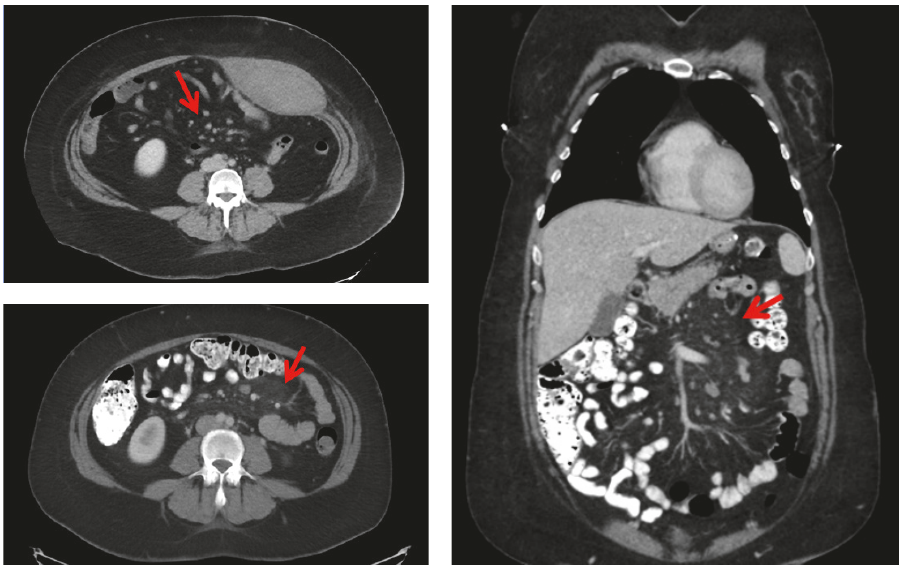
Figure 1: Red arrows pointing to hyperattenuated mesentery in the left